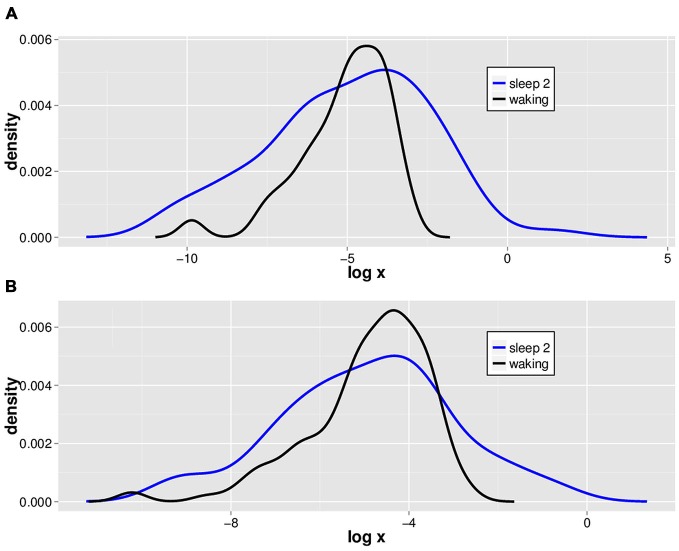
Typical natural log scale probability distribution estimations for positive and negative LVDs. LVDs were isolated at 2.5 SD from positive (A) and negative (B) voltage deflections from a 1 min segment of waking (black) and sleep stage 2 (blue) EEG tracings from one subject for illustration purposes.